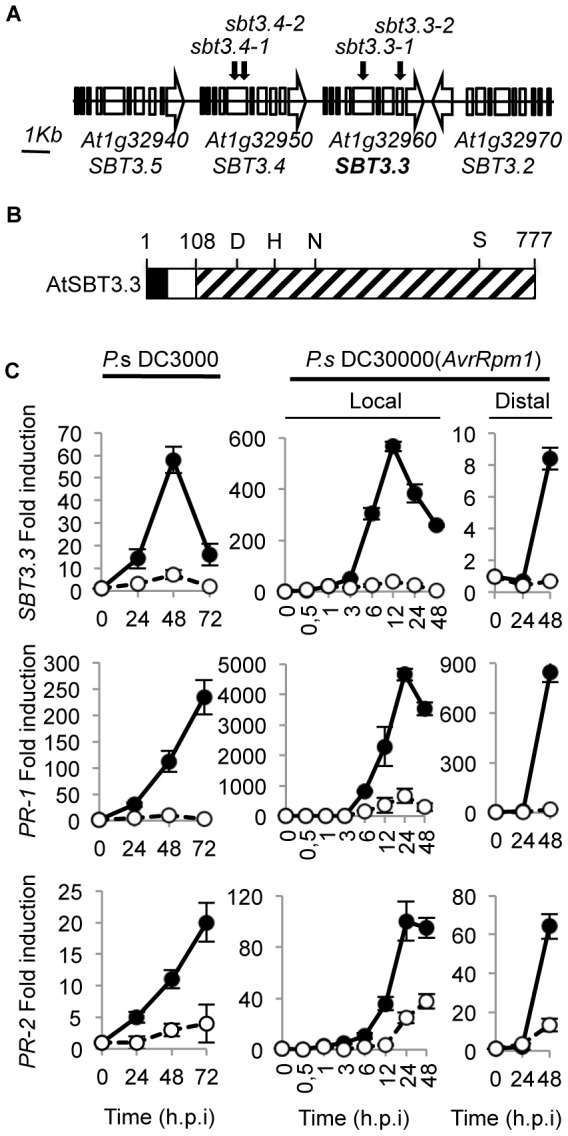

SBT3.3 genome organization and induced expression following P.

syringae
 DC3000 infection.
A) Four SBT3.3-like open reading frames sequences (named as SBT3.5, SBT3.4, SBT3.3 and SBT3) are arranged in tandem in chromosome I. The distances are only approximate. Arrowheads indicate direction of transcription. Black arrows above the genes show position of T-DNA insertions rendering the sbt3.4 and sbt3.3 mutant alleles. (B) Schematic representation of the SBT3.3 preproenzyme structure. Areas marked respectively in black, white and stippled indicate the signal peptide, propeptide, and mature peptide regions. Numbers depict positions of amino acid residues from the N-terminus. The amino acids forming the catalytic triad (D, H, and S) and the conserved N residues are marked. (C) RT-qPCR analyses showing local induction of SBT3.3, PR-1, and PR-2 gene expression upon infection with virulent PsDC3000, and both local and distal induction following infection with the avirulent PsDC3000 (AvrRpm1) strain. Filled circles represent inoculated plants, and empty circles represent mock-inoculated plants (controls). Data represent mean ± SD, n = 3 replicates. Expression was normalized to the constitutive ACT2 gene, then to expression at time 0 in Col-0 plants.